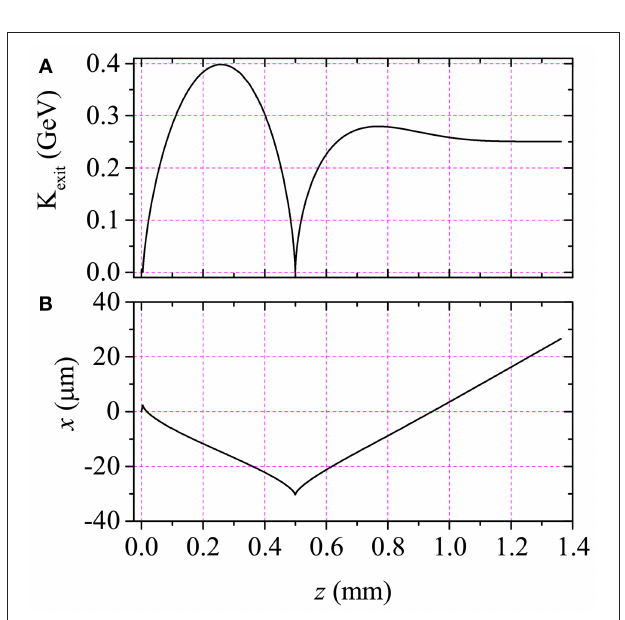
FIGURE 5 | (Color online) Same as Figure 4 , albeit for acceleration from rest ( γ 0 =